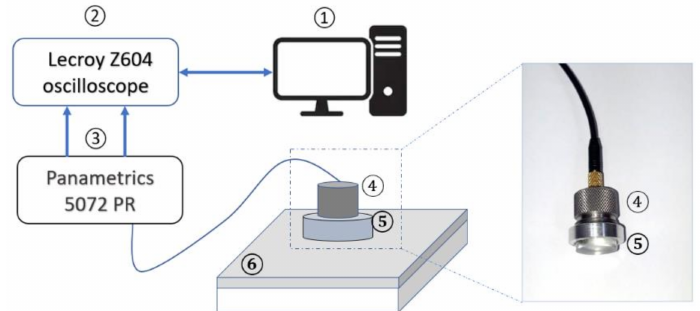
Figure 3. Experimental set-up: (1) computer; (2) Lecroy oscilloscope; (3) pulser receiver; (4) piezo- electric transducer; (5) acrylic delay line; and (6) specimen.